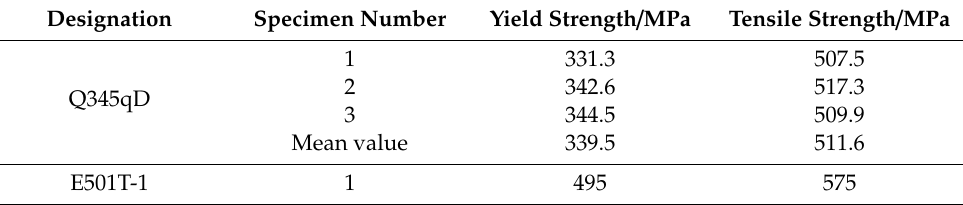
Table 2. The mechanics performance of Q345qD and the welding